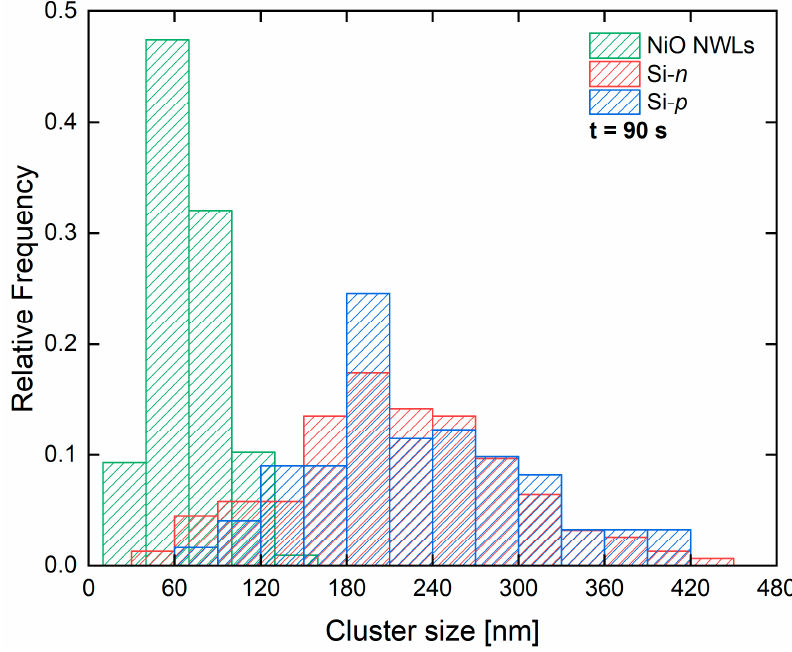
Figure 2. Cluster size distribution for NiO NWLs_90, Si- n _90 and Si- p _90 samples.